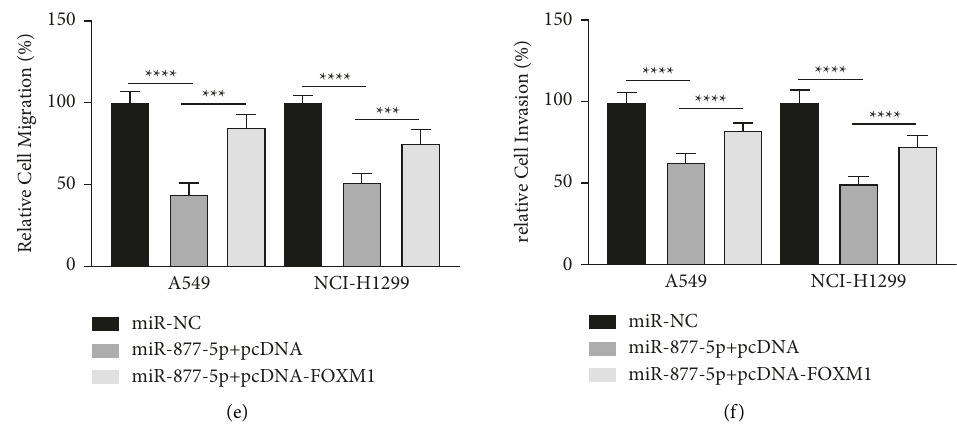
Figure 5: Restoration of FOXM1 expression reverses the antitumor effect of miR-877-5p in NSCLC cells. A549 and NCI-H1299 cells transfected with miR-NC, miR-877-5p+pcDNA, or miR-877-5p +pcDNA-FOXM1, respectively. (a) The expression of FOXM1 mRNA in transfected A549 and NCI-H1299 cells. (b) Protein levels of FOXM1 in transfected A549 and NCI-H1299 cells. The proliferation of transfected A549 (c) and NCI-H1299 (d) cells. (e) Migration assays of transfected A549 and NCI-H1299 cells. (f) Invasion assays of transfected A549 and NCI-H1299 cells. ∗ P < 0 . 05, ∗∗ P < 0 . 01, ∗∗∗ P < 0 . 001, and ∗∗∗∗ P < 0 .